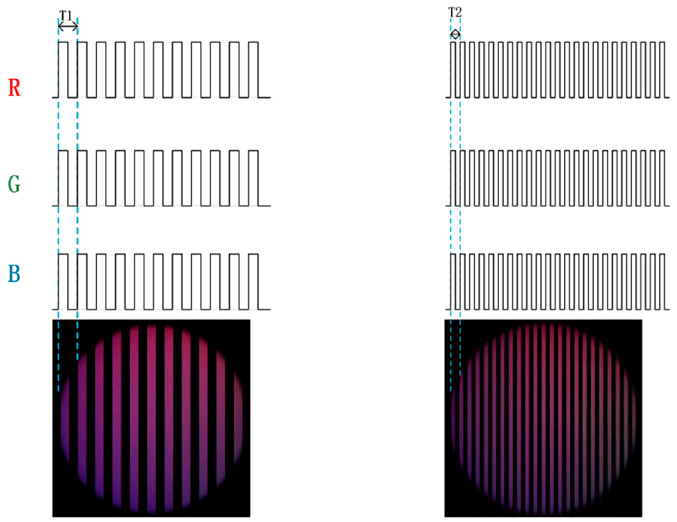
Figure 2. The effect of different frequencies.